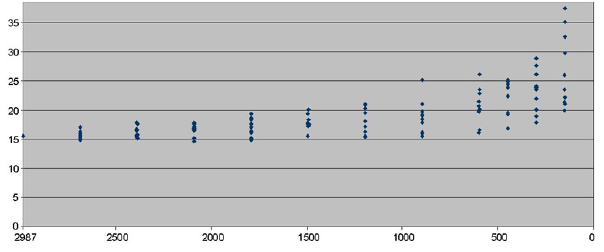
Figure 3. Rainfall, July 2007 – Estimated root-mean-square errors (mm) at a subset of 20 independent points, as a function of the num- ber of stations remaining out of the original 3007 available (ten runs were made for each proportion of stations